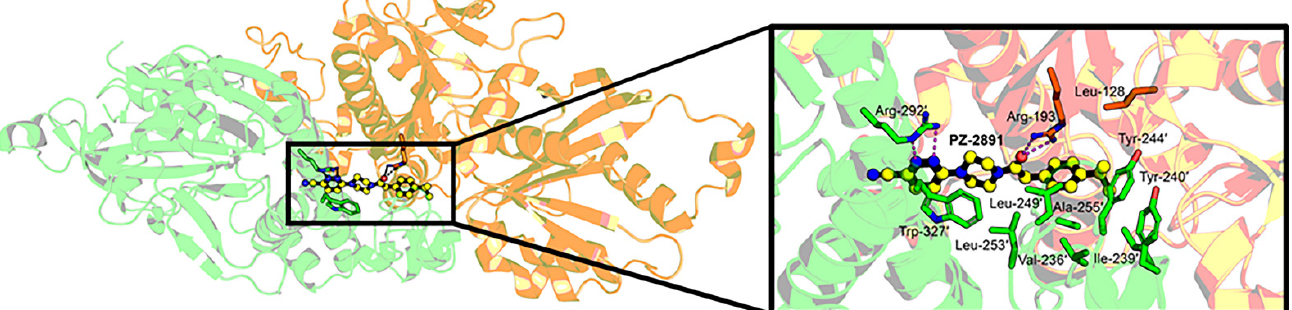
Figure 3. Homology model of A. stephensi PanK with bound PZ-2891. Interactions between PZ-2891 and A. stephensi PanK predict that the mosquito protein is regulated by the same allosteric mechanism described for PZ-2891 regulation of human PanKs. PZ-2891 interacts with both protomers through hydrophobic interactions, hydrogen bond contacts, and π - π stacking interactions. Sequence numbering is assigned to A. stephensi PanK. The two A. stephensi PanK protomers are colored green and orange and PZ-2891 is yellow.